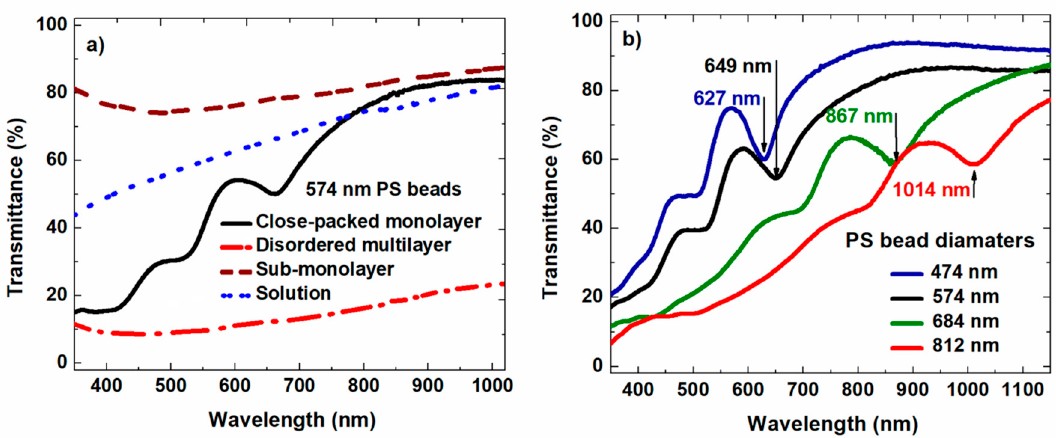
Figure 3. Measured transmission spectra of ( a ) 574 nm PS beads suspended in solution, as a sub-monolayer, as a multilayer, and as a close-packed monolayer (dotted blue, dashed brown, dash–dotted red, and solid black lines, respectively) and of ( b ) self-assembled films of PS beads with diameters of 474, 574, 684, and 812 nm. The transmission dips in the spectra shift to longer wavelengths as the size of the beads increases.